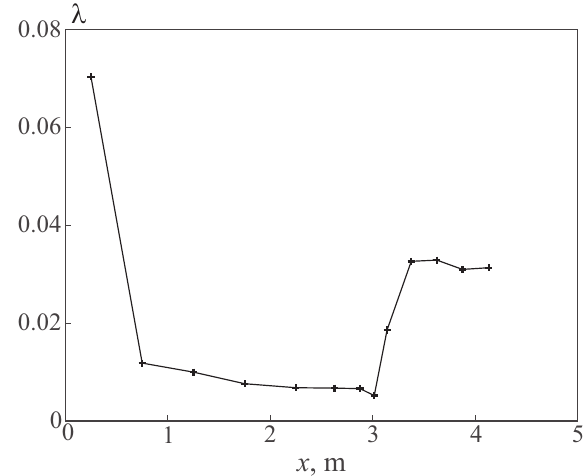
Figure 14. Distribution of the coefficient of friction along the length of the